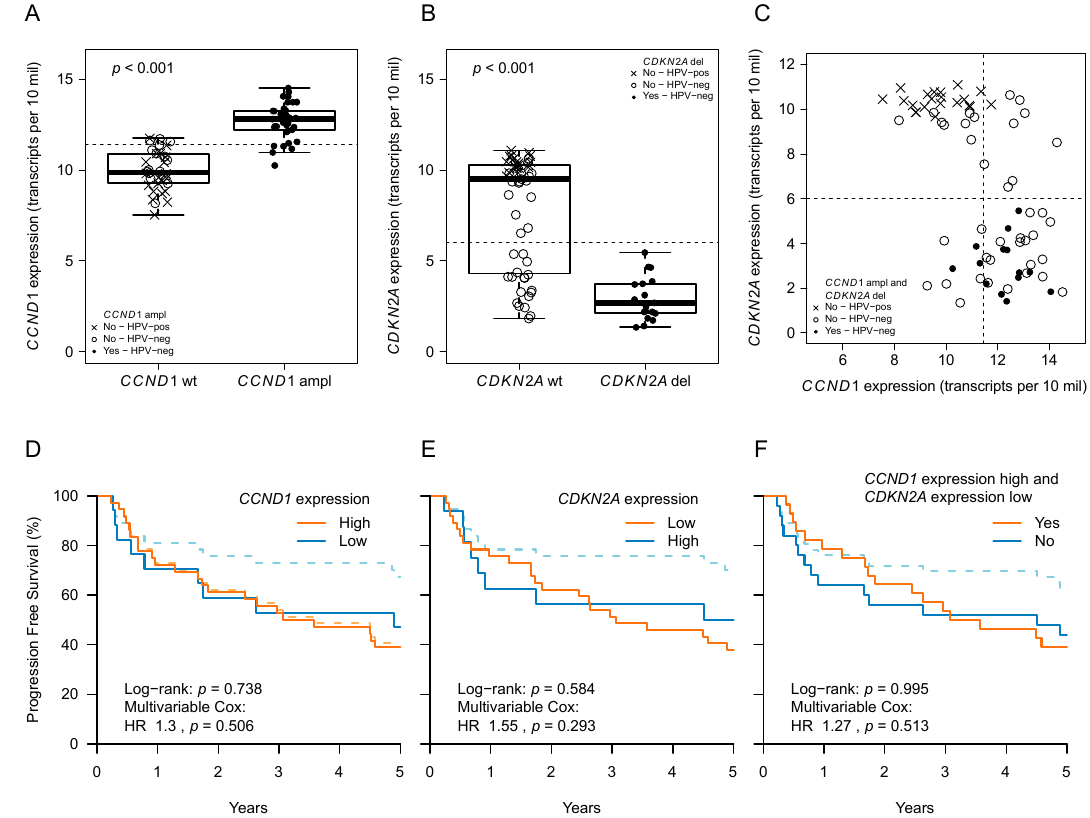
Figure 2. CCND1 and CDKN2A expression and patient outcome. ( A ) CCND1 expression in tumors with (‘ampl’) and without (‘wt’) CCND1 amplification. ( B ) CDKN2A expression in tumors with (‘del) and without (‘wt’) CDKN2A deletion. ( C ) CDKN2A against CCND1 expression per tumor sample, colored according to the presence (filled circles) or absence (open circles) of a co-occurring CCND1 amplification and CDKN2A deletion. Dashed lines demarcate the median expression, according to which the samples received a high or low expression classification in D–F. ( D – F ) Kaplan–Meier curves of progression free survival (PFS) according to CCND1 and CDKN2A expression status. Dashed lines represent all samples; solid lines represent HPV-negative samples only. Note, orange lines overlap in E–F. In-figure legends in D–F state hazard ratios (HR) and corresponding p -values from multivariable Cox models that were fitted on all ( n = 77) samples and included the tested genetic factor, HPV status, and tumor site. In-figure stated log–rank tests correspond to the analyses in HPV-negative samples only.